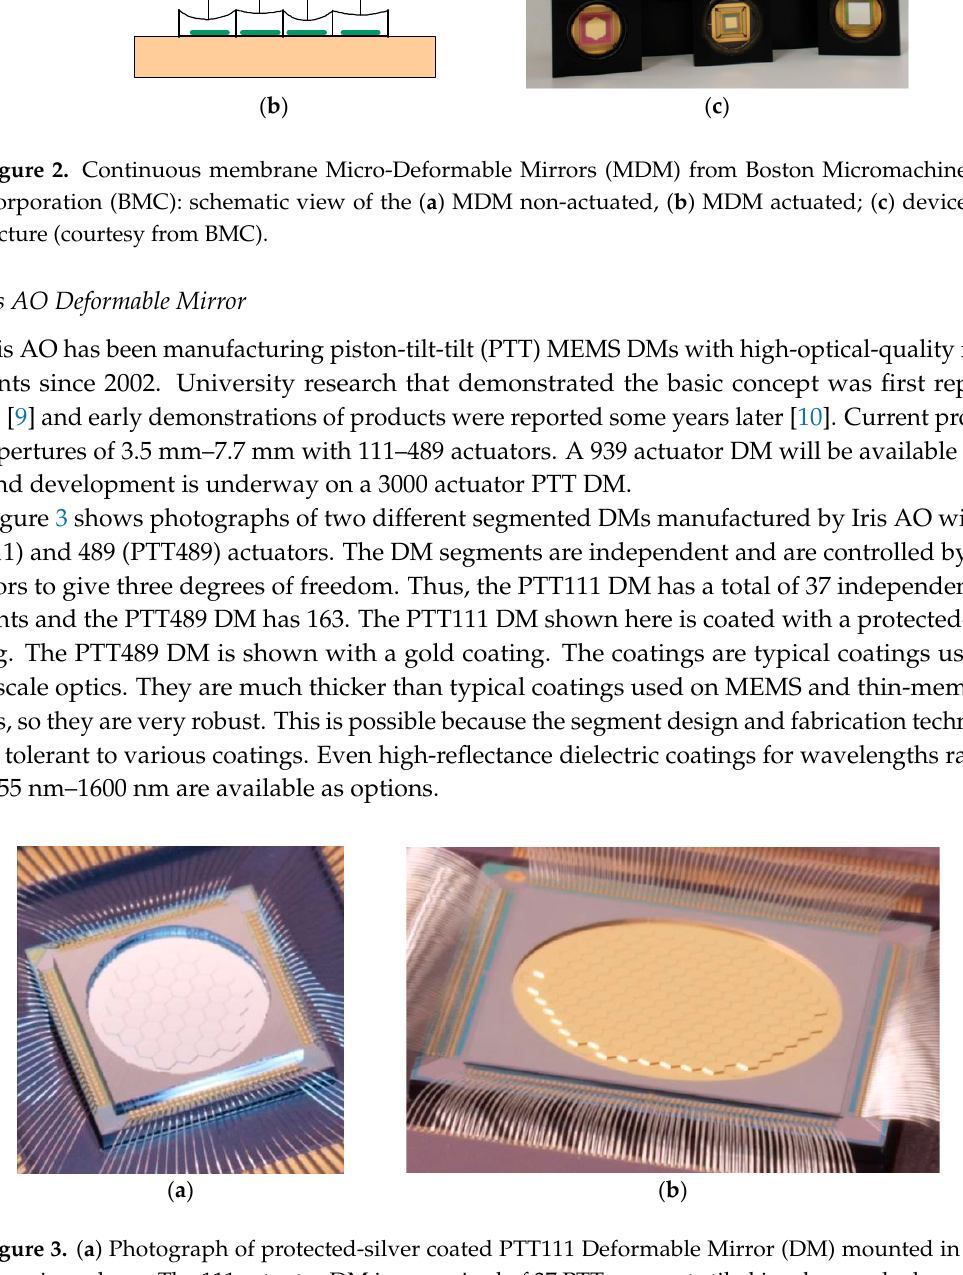
with an inscribed aperture of 3.5 mm; ( b ) Photograph of gold-coated PTT489 DM. The 489 actuator